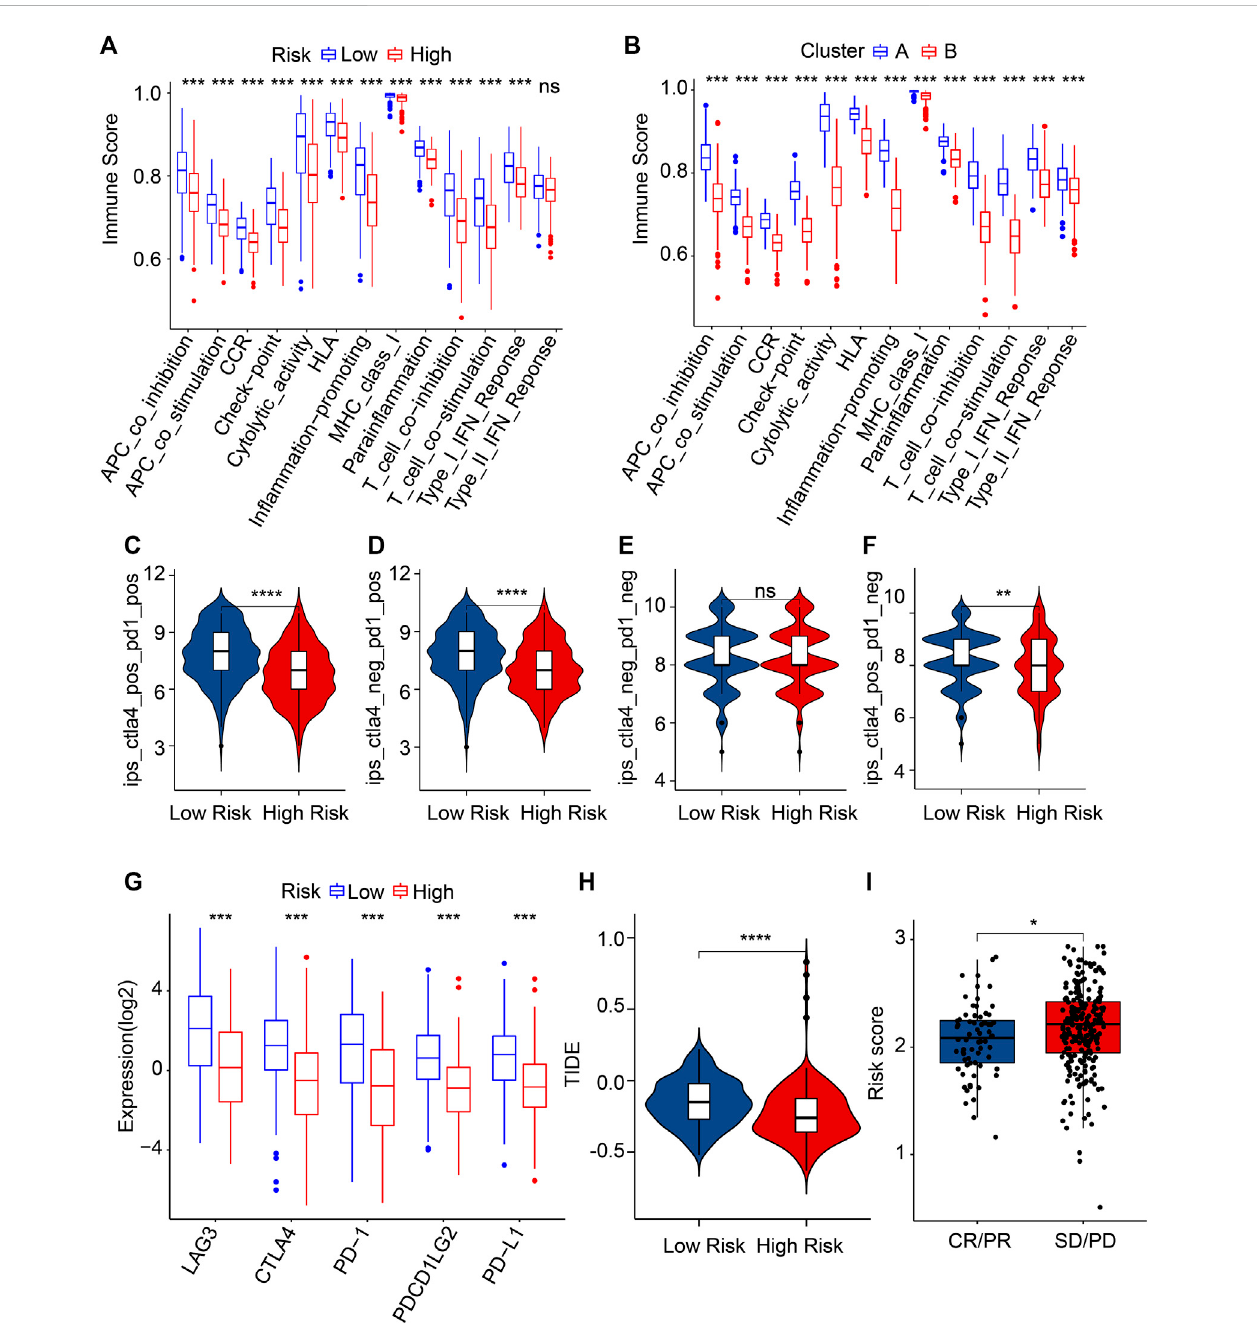
FIGURE 8 Evaluation of immune function score and immunotherapy response. (A) Immune function score of patients in the different risk groups. (B) Immune function score of patients in the clusters. (C – F) Immunophenoscore (IPS). (G) The expression of ICI in the low- and high-risk groups. The expression is transformed by log2 (expression +1). (H) TIDE score. (I) The risk score in the IMvigor210 cohort. PR, partial response; PD, progressive disease; SD, stable disease; CR, complete response. * p < 0.05, ** p < 0.01, *** p < 0.001, **** p <